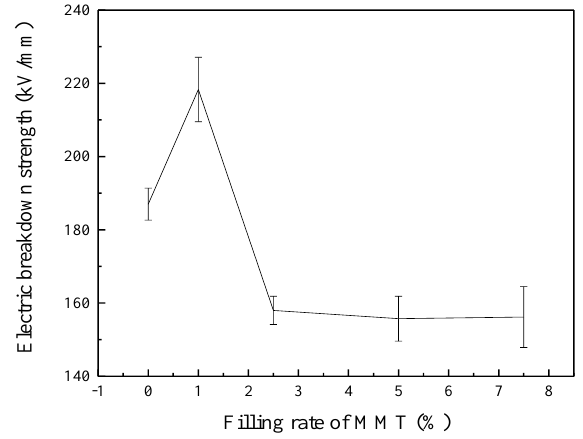
Figure 8. The electric breakdown strength of nano-composite pressboards varying with filling rate.